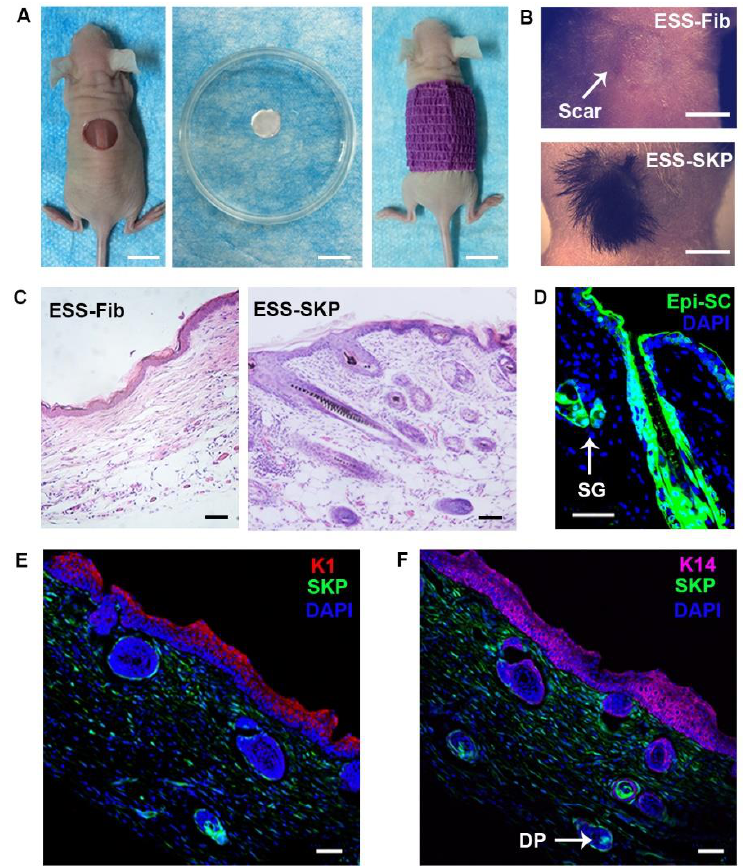
Figure 6. SKP-induced hair genesis in a C-GAG matrix. ( A ) The ESS was prepared by seeding a mixture of culture-expanded murine SKPs (or dermal fibroblasts as a control) and neonatal Epi-SCs into a C-GAG matrix (named as ESS-SKP or ESS-Fib), and was incubated for 2 h (middle). The ESSs were then transplanted into full-thickness wounds in nude mice (right). The wounds were finally dressed with Tegaderm and bandage (left). ( B ) Three weeks later, the wounds which received ESS-SKP (lower) healed with black hairs grown, while the wounds which received ESS-Fib (upper) healed without hair grown. Scale bars: 10 mm. ( C ) Histological analysis showed that the wounds which received ESS-SKP had densely-populated hair follicles and sebaceous glands in the dermis, while the wounds which received ESS-Fib showed fibrotic structure in the dermis (H&E stain). Scale bars: 50 μm . ( D – F ) Fluorescence analysis of the ESS-SKP treated wound. ( D ) The newly-formed hair follicles and sebaceous glands were derived from the donor Epi-SCs expressing GFP. SG: sebaceous glands. Scale bar: 50 μm . ( E , F ) The donor SKPs contributed to spindle-shaped cells in the dermis and the DP in the hair follicle. The neoepidermis showed a ‘ stratified ’ epidermis, revealing a normal pattern of differentiation. Scale bars: 50 μm.